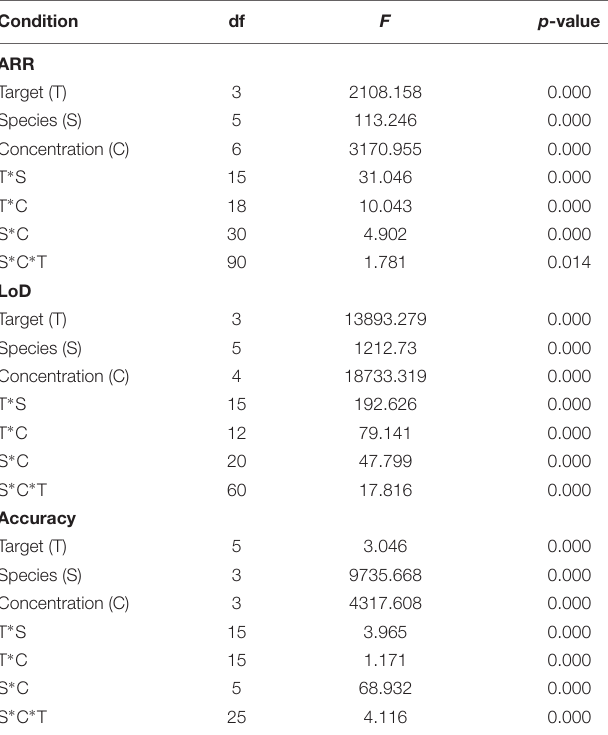
TABLE 2 | Results of the Factorial ANOVA – Threshold Cycle (Ct) to determine multivariate interactions among target, species and concentration in the ARR, LoD and Accuracy